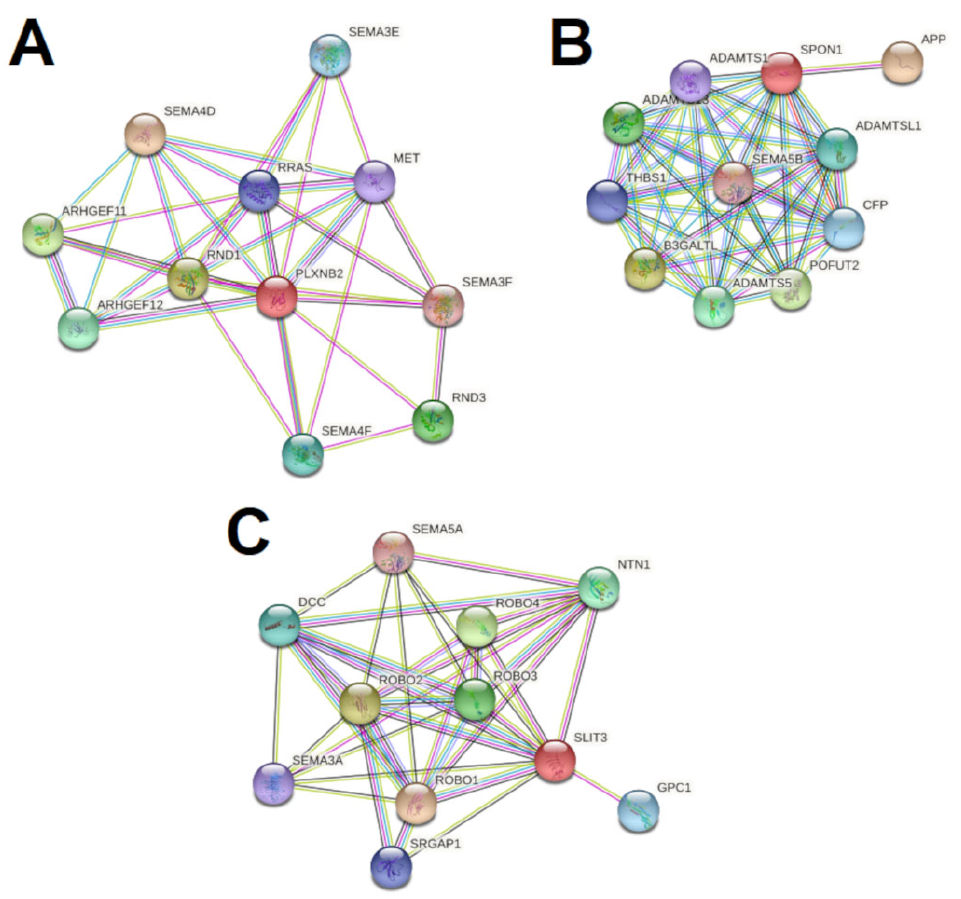
Genetic and proteomic associations for PLXNB2, SLIT3, and SPON1 are shown in Figure 5. PLXNB2 was found to interact with several members of the semaphorin family. SPON1 was associated with several ADAMTS family members. SLIT3 interacts with several proteins in the Roundabout (ROBO) family.